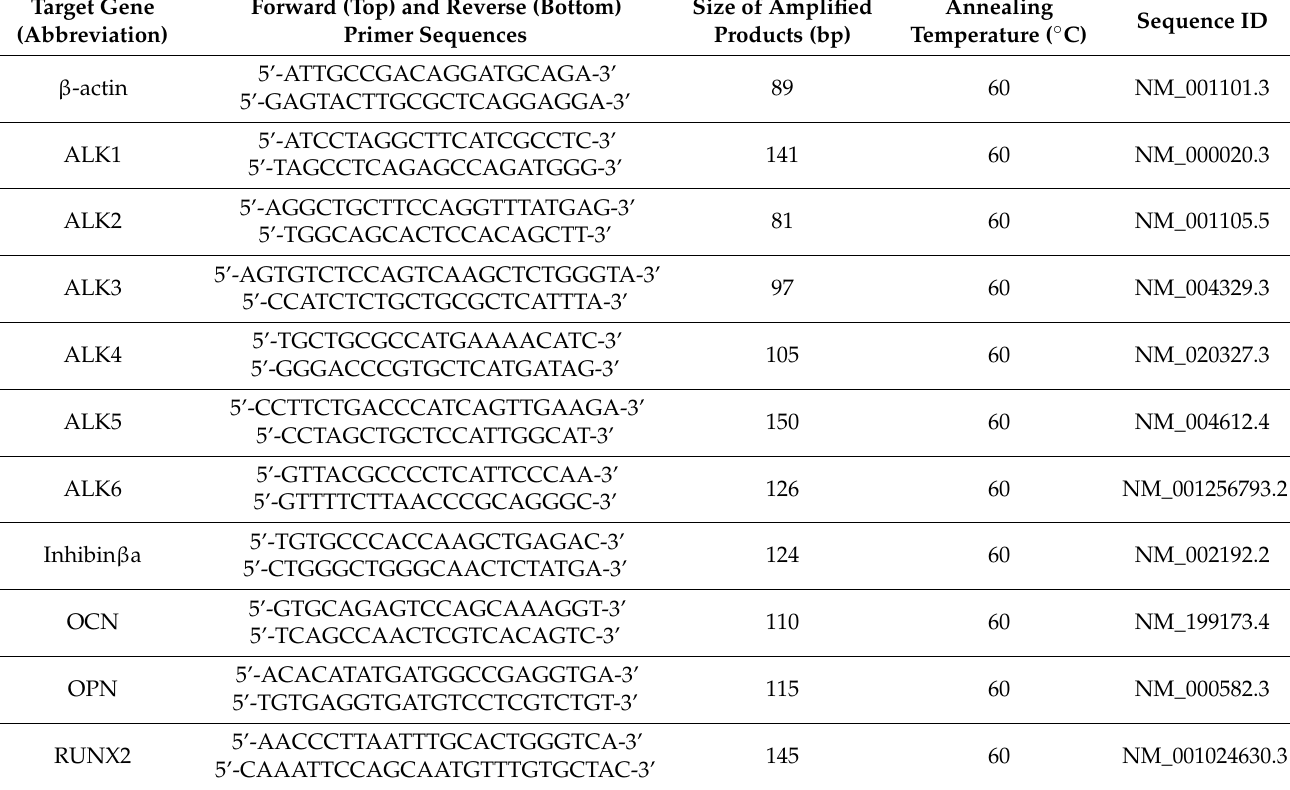
Table 1. Primer sequence, product size, annealing temperature, for quantitative